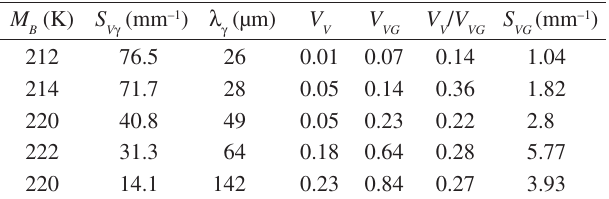
Figure 1. Optical photomicrographs of a Fe-31%Ni-0.02%C cooled to the burst temperature, 212-222 K: a) Fine grain size, b) Coarse grain size. The reaction is better spread over the material with the coarse grain size. Table 1. Bulk Fe-31 mass% Ni-0.02 mass% C burst parameters 5-6